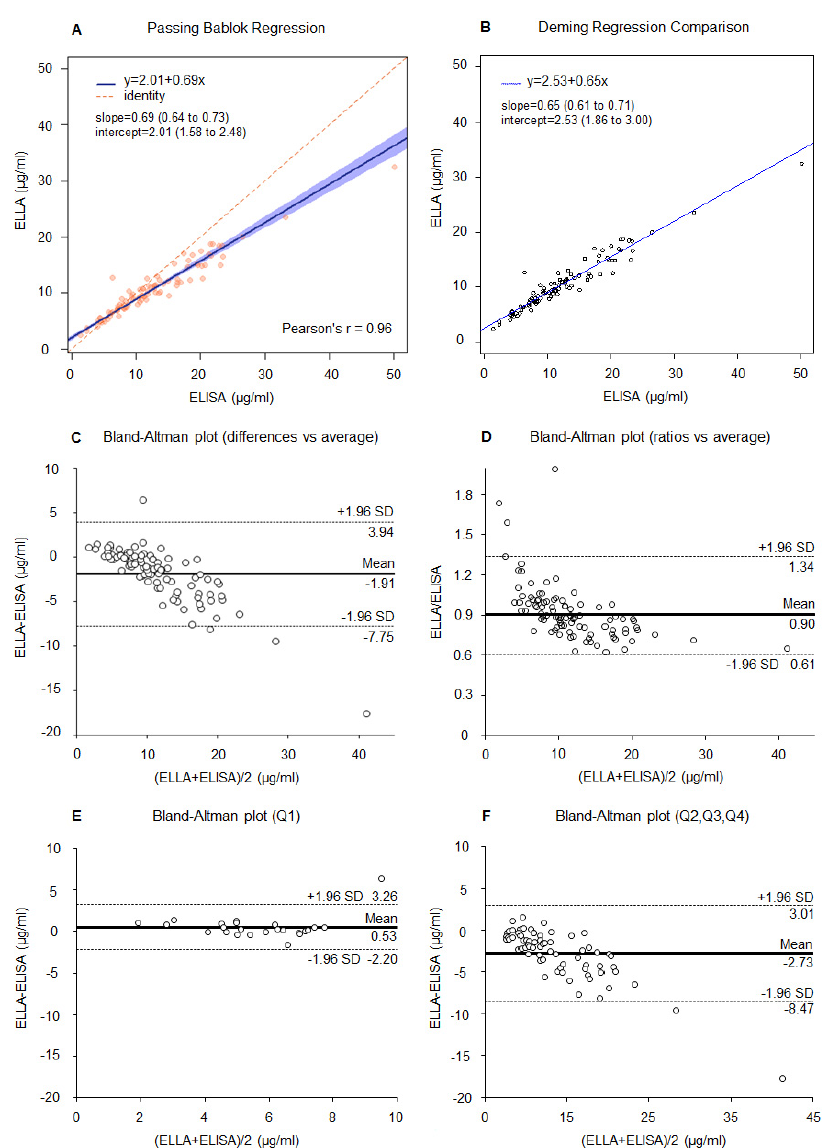
Figure 2. Correlation between ELLA (2-step dilution protocol) and ELISA for adiponectin measure- ment ( n = 95). ( A ) Passing–Bablok and Pearson’s r coefficient, ( B ) Deming regression, ( C ) Bland– Altman plot (differences vs. average), ( D ) Bland–Altman plot (ratio vs. average), ( E ) Bland–Altman plot (differences vs. average) for adiponectin < 6.75 µ g/mL (<first quartile Q1), and ( F ) for adiponectin ≥ 6.75 µ g/mL ( ≥ first quartile, Q2-3-4). Dashed lines represent 95%